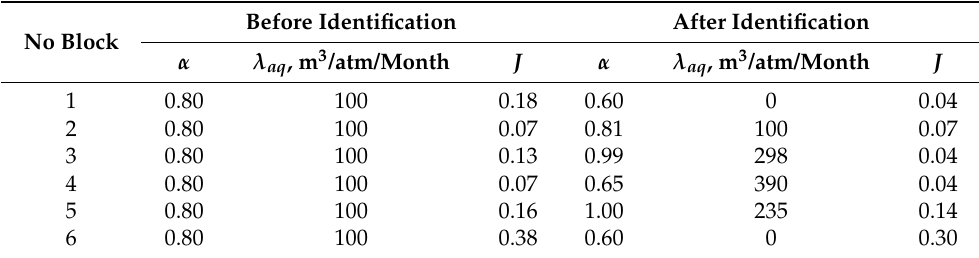
Table 1. Calculated